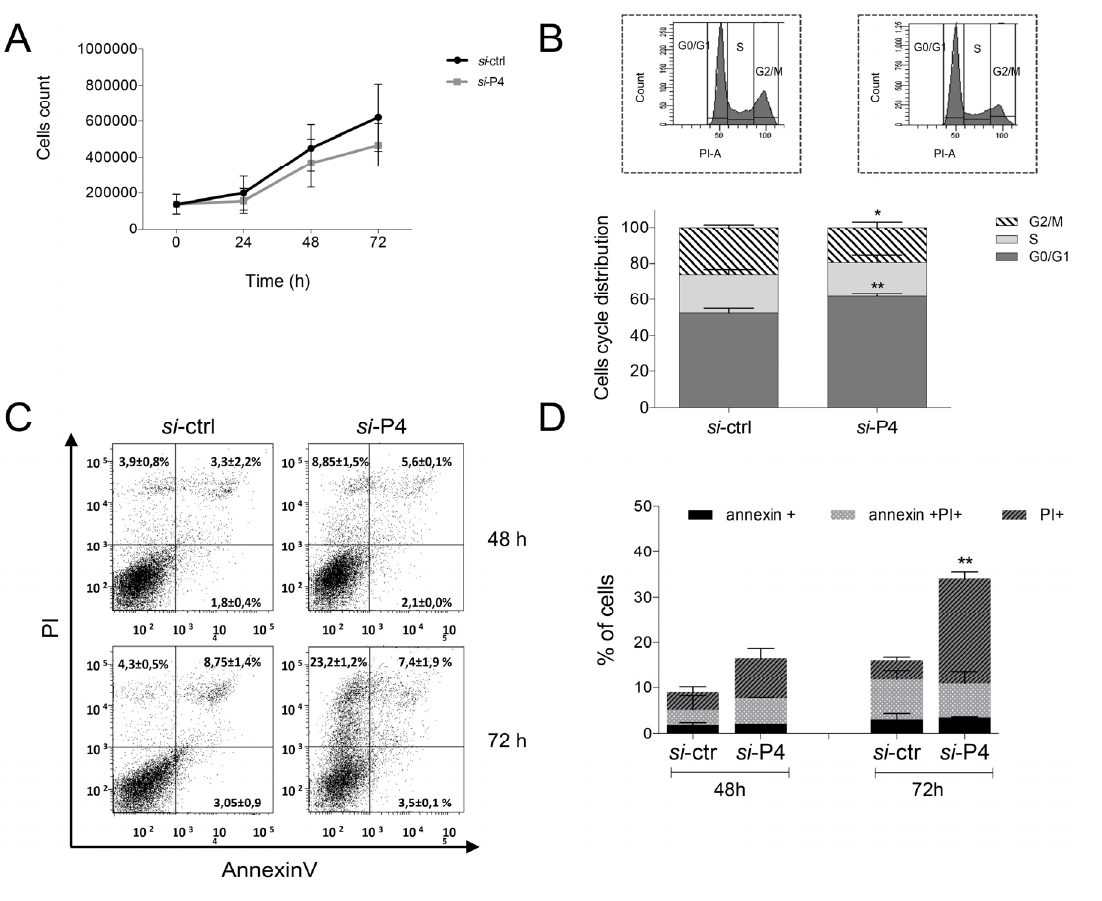
Figure 4. Proliferation phenotype of J82 bladder cells following PA2G4P4 silencing. ( A ) Growth rates evaluated at di ff erent time points counted using a Bürker chamber and trypan blue staining. ( B ) Analysis of cell cycle distribution in the G0 / G1, S, and G2 / M phases. The upper panel